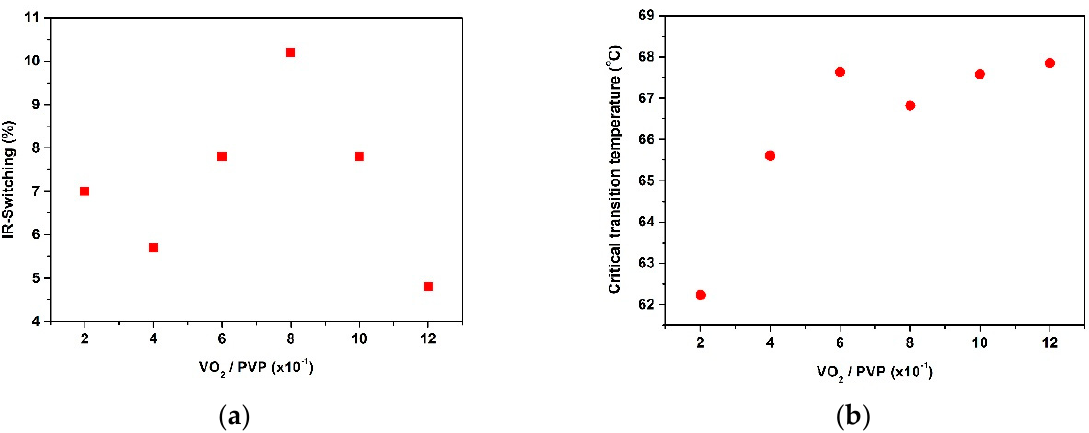
Figure 5. Effect of the VO 2 /PVP molar ratio on thermochromic characteristics of VO 2 /PVP nanocomposite films. ( a ) IR switching ( Δ Tr IR ), as calculated by Equation (4) at λ = 2000 nm and ( b ) critical transition temperature ( T C ).